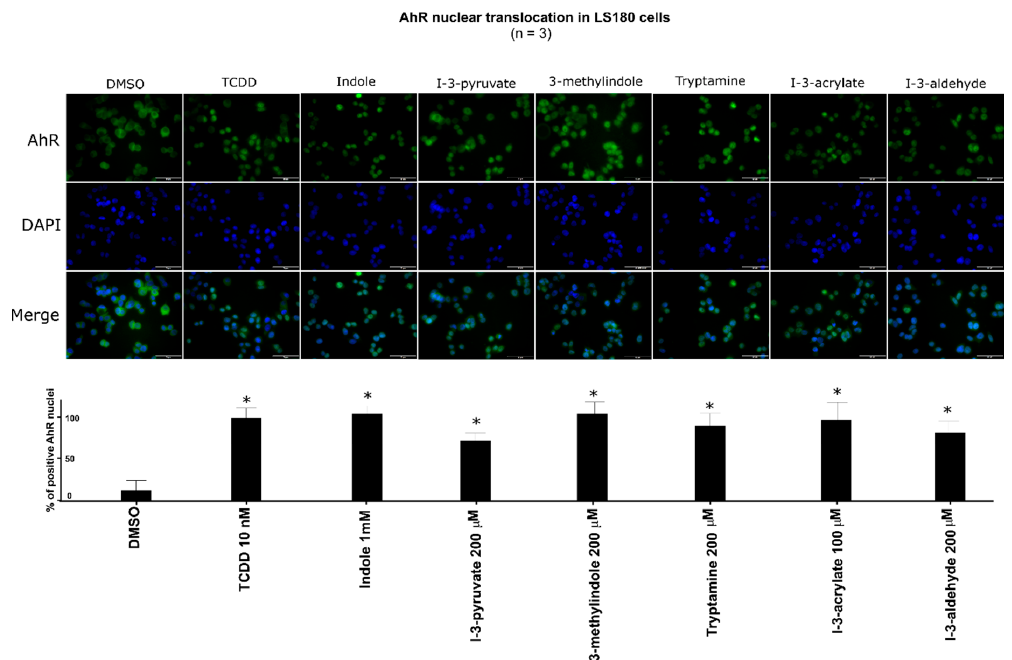
Figure 5. Effect of MICT on nuclear translocation of the AhR. LS180 cells were incubated for 90 min with vehicle (DMSO; 0.1% V / V ), TCDD (10 nM), and test MICT. The experiments were performed in three consecutive cell passages with all tested compounds in duplication. Fluorescence images depict sub-cellular localization of AhR (upper panels) and nuclear staining by DAPI (lower panels). Representative micrographs are shown. The bar graph shows the percentage of AhR positive nuclei (mean ± SD; n = 3) relative to TCDD-treated cells (also ref. Supplementary Table S1). * = a value significantly different from negative control ( p < 0.05).